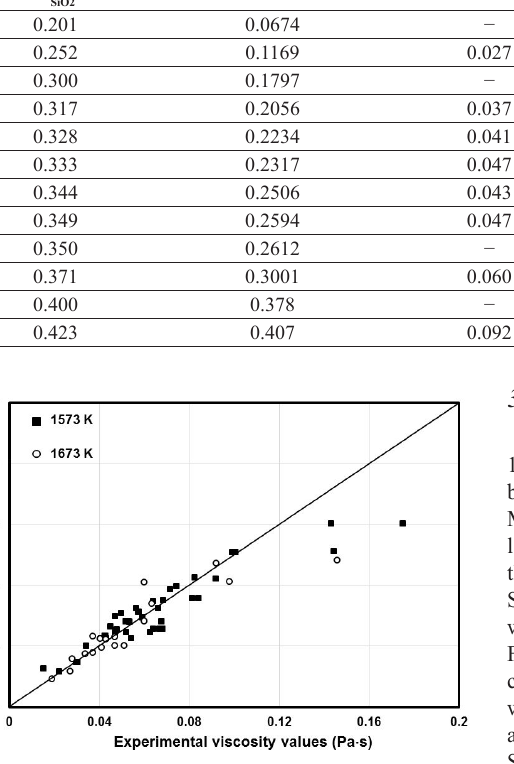
Figure 4. Comparison of the calculated and experimental (14,17-20) viscosities for the SiO −FeO 2